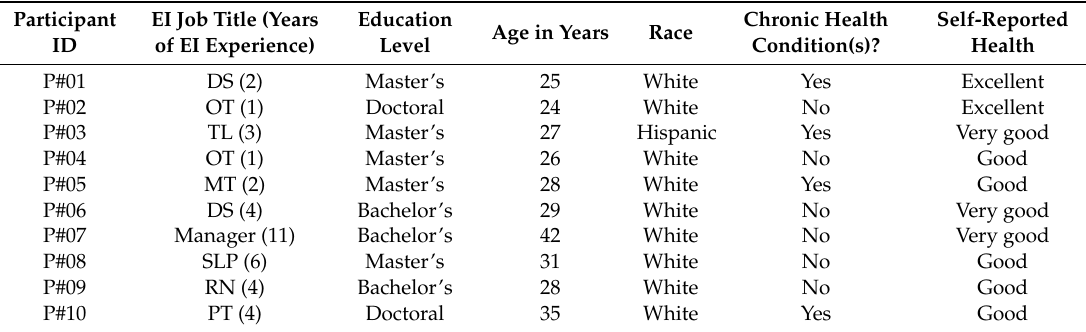
Table 2. Profiles of early intervention (EI) providers ( n = 10, all